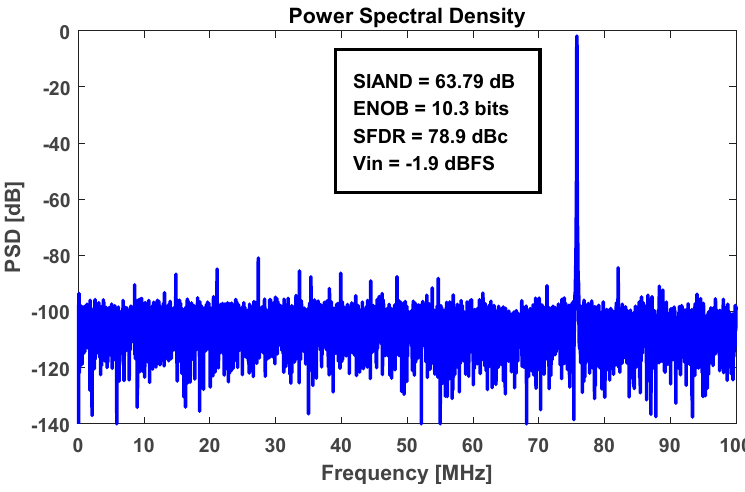
Figure 11. Dynamic performances after calibration.